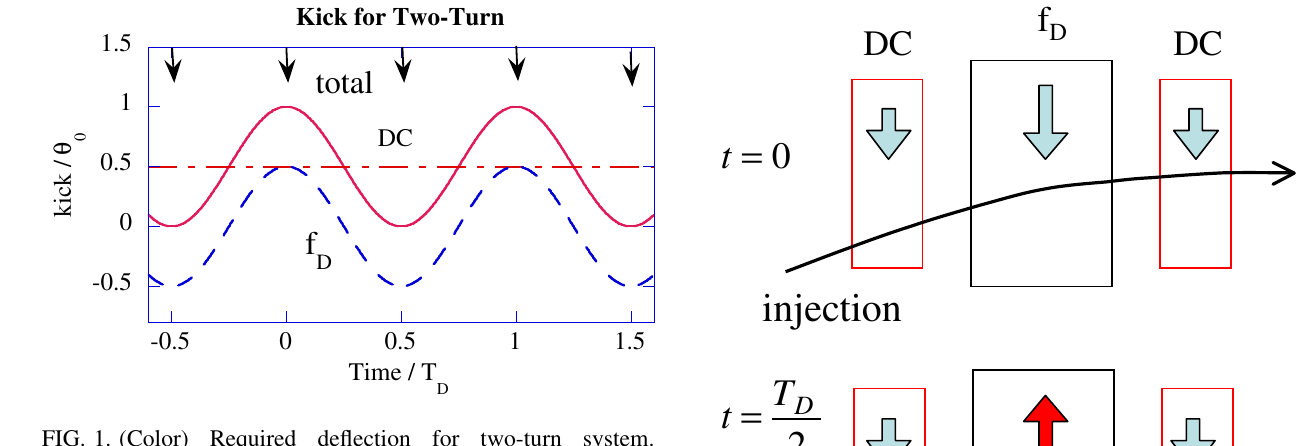
D = 2 , indicated by D